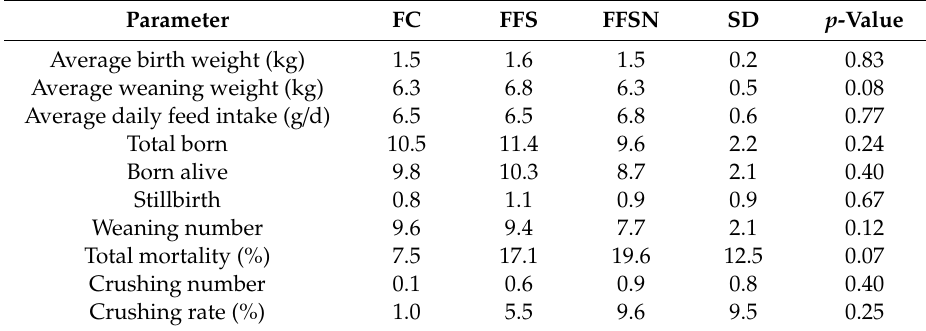
Table 2. Piglet production and loss for sows in di ff erent farrowing